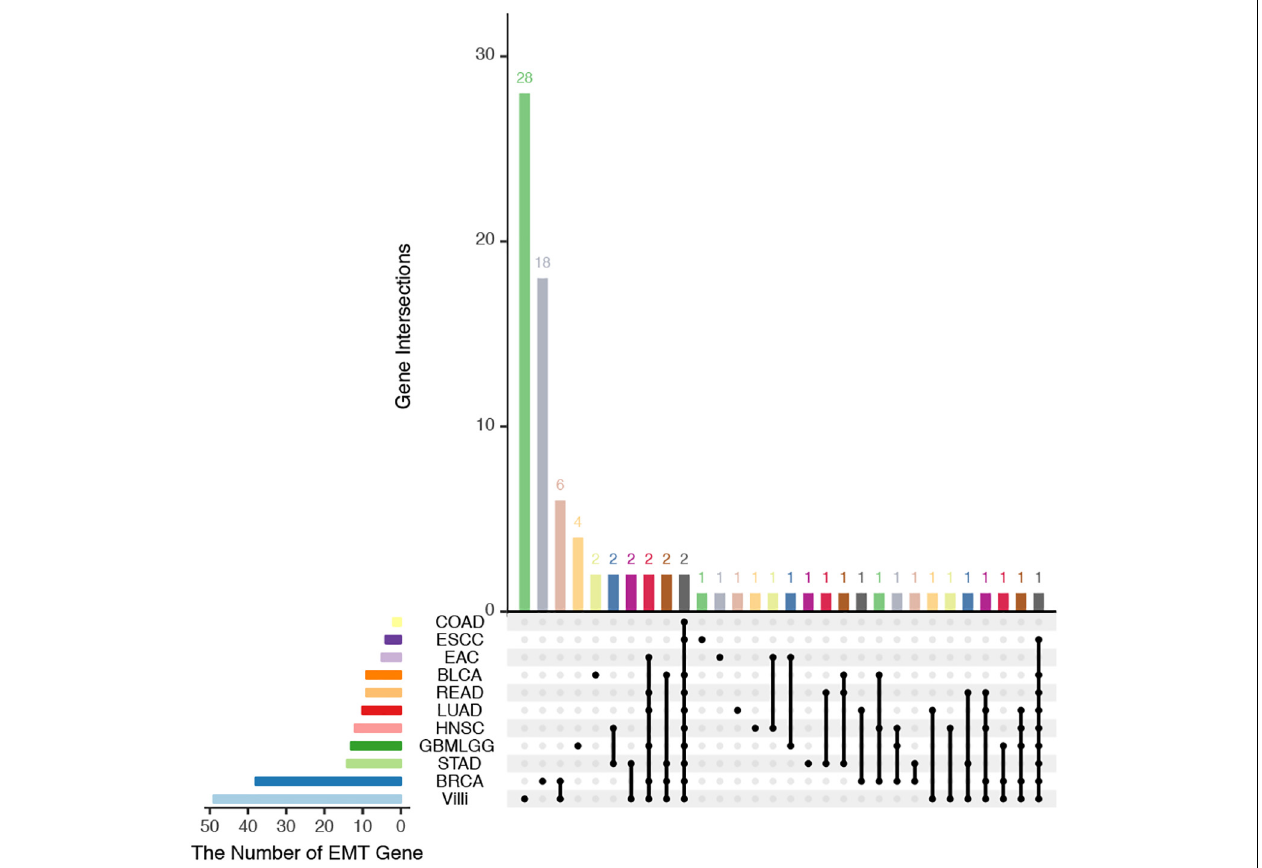
FIGURE 2 | UpSet plot of the intersection of EMT-related genes between villi and cancers. The transverse bar graph at the bottom left shows the number of EMT-related genes in each set. The black points in the dot matrix at the bottom left and in the bar graph at the top indicate genes included in the correlation set. The bars above represent the number of genes corresponding to each intersection.